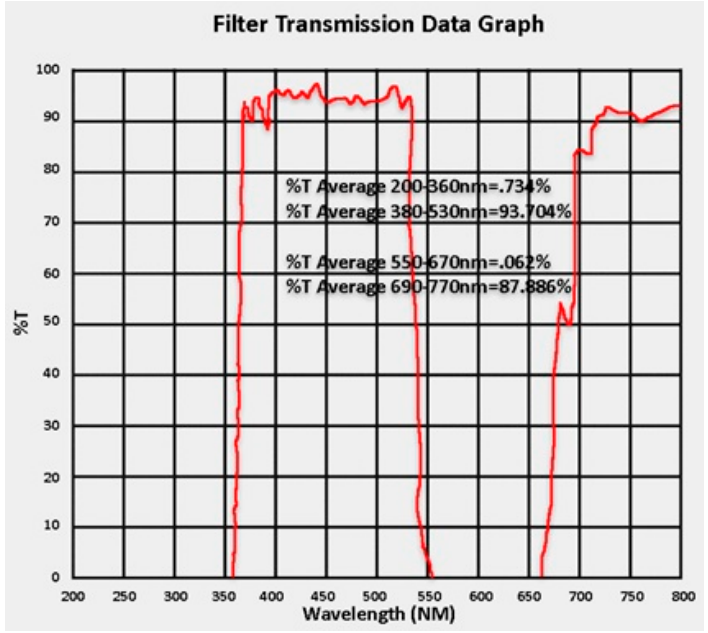
Figure 1. Transmission bands of the camera filter.